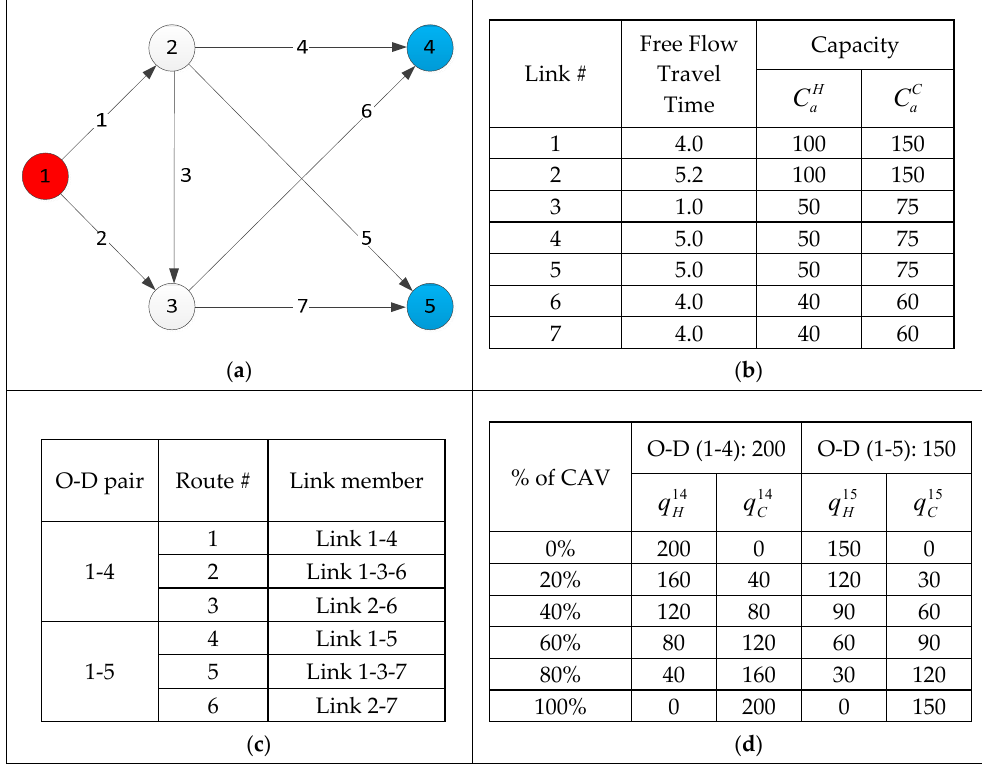
Figure 4. Network topology and features of the small network. ( a ) Test network; ( b ) link characteristics; ( c ) route set, ( d ) O-D demand with % of CAVs.